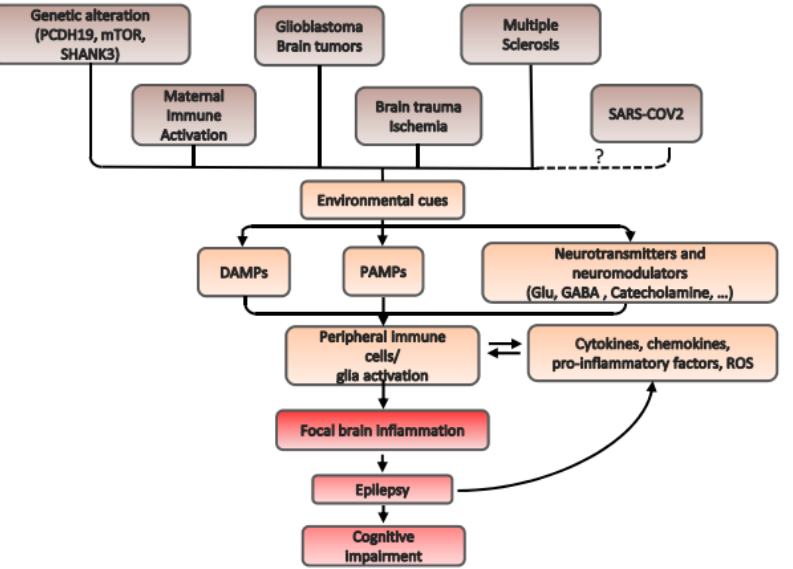
Figure 1. Schematic diagram of the interaction between epilepsy and neuroinflammation. Epilepsy is related to neuroinflammation and neuroinflammation can induce epilepsy in a biunivocal interaction. Many molecular mechanisms have been described to be involved in this loop. Diverse mechanisms, here summarized in the diagram, can impinge by means of the interaction with environmental cues on damage-associated molecular patterns (DAMPs), pathogen-associated molecular patterns (PAMPs) or on neurotransmitters and neuromodulators. Dotted lines and question mark indicate the possible involvement of SARS-COV2 in this loop; studies about its mechanism of action are currently ongoing.